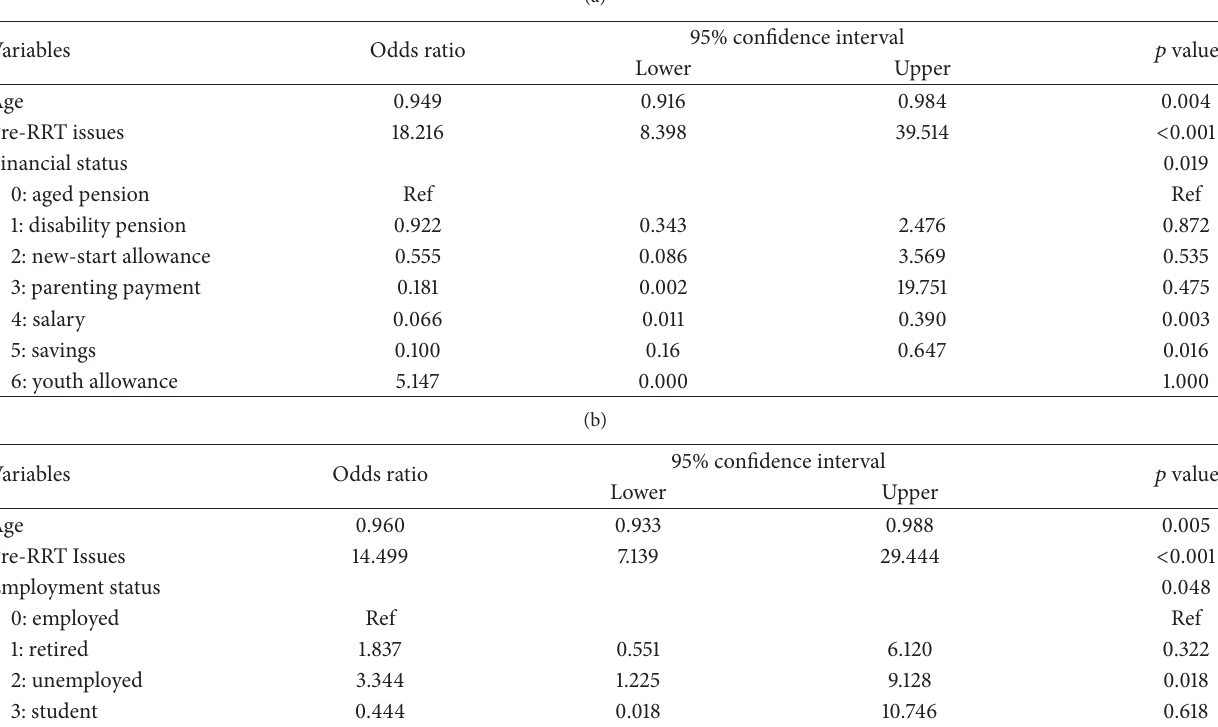
Table 3: Multivariate logistic regression for independent predictors of adjustment issues.